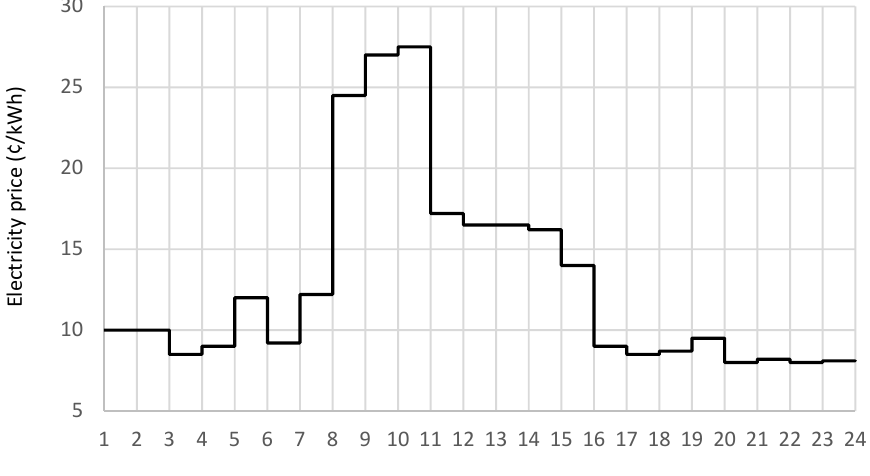
Figure 3. The hourly changing electricity prices, with the slots.